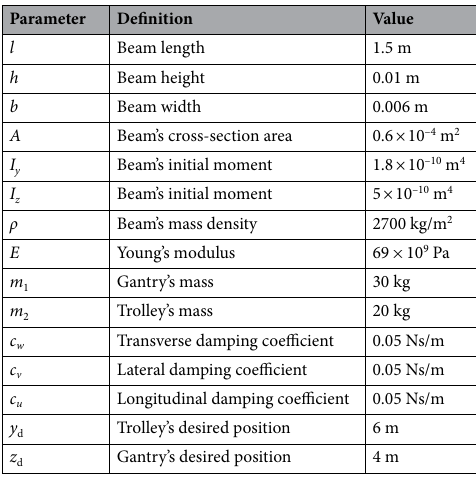
Table 1. System parameters.